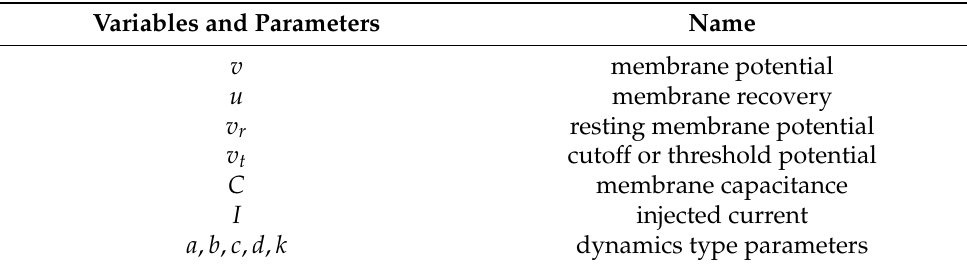
Table 1. Variables and parameters of the Izhikevich model.